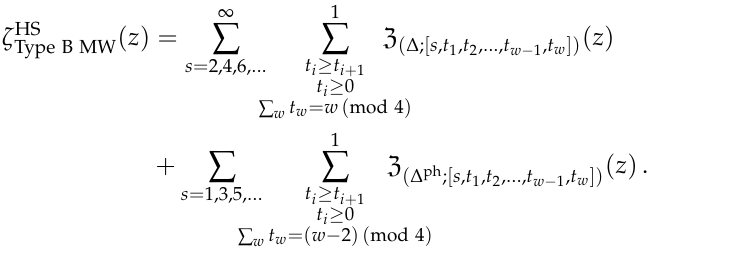
Table 3. Projection of the non-minimal Type B theory to the Majorana/symplectic Majorana minimal Type B theory in even d . Notice that in AdS 7 and AdS 15 , where we impose a symplectic Majorana projection, the pattern does not exactly follow the one seen in the other dimensions, as explained in the text. Instead, they are ‘inverted’, with the swapping of the towers for each weight from being only even integer spins to only odd integer spins. Their shift is highlighted in cyan. As defined earlier, the subscript ‘ c ’ indicates that both self-dual and anti-self-dual parts are included, corresponding to the weights [ t 1 , . . . , t k − 1 , t k ] and [ t 1 , . . . , t k − 1 , − t k ]